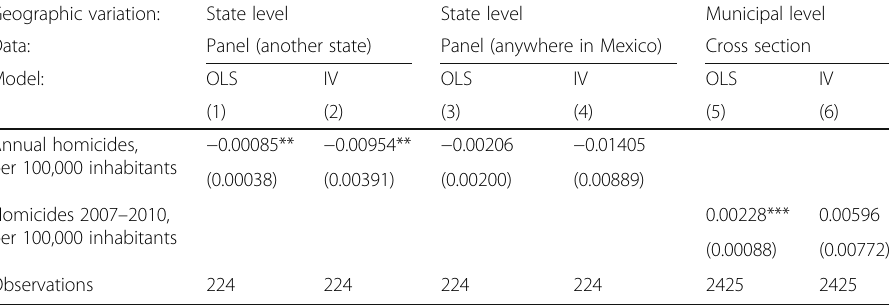
Table 4 OLS and second stage IV results: domestic migration Geographic variation: State level State level Municipal level Data: Panel (another state) Panel (anywhere in Mexico) Cross section Model: